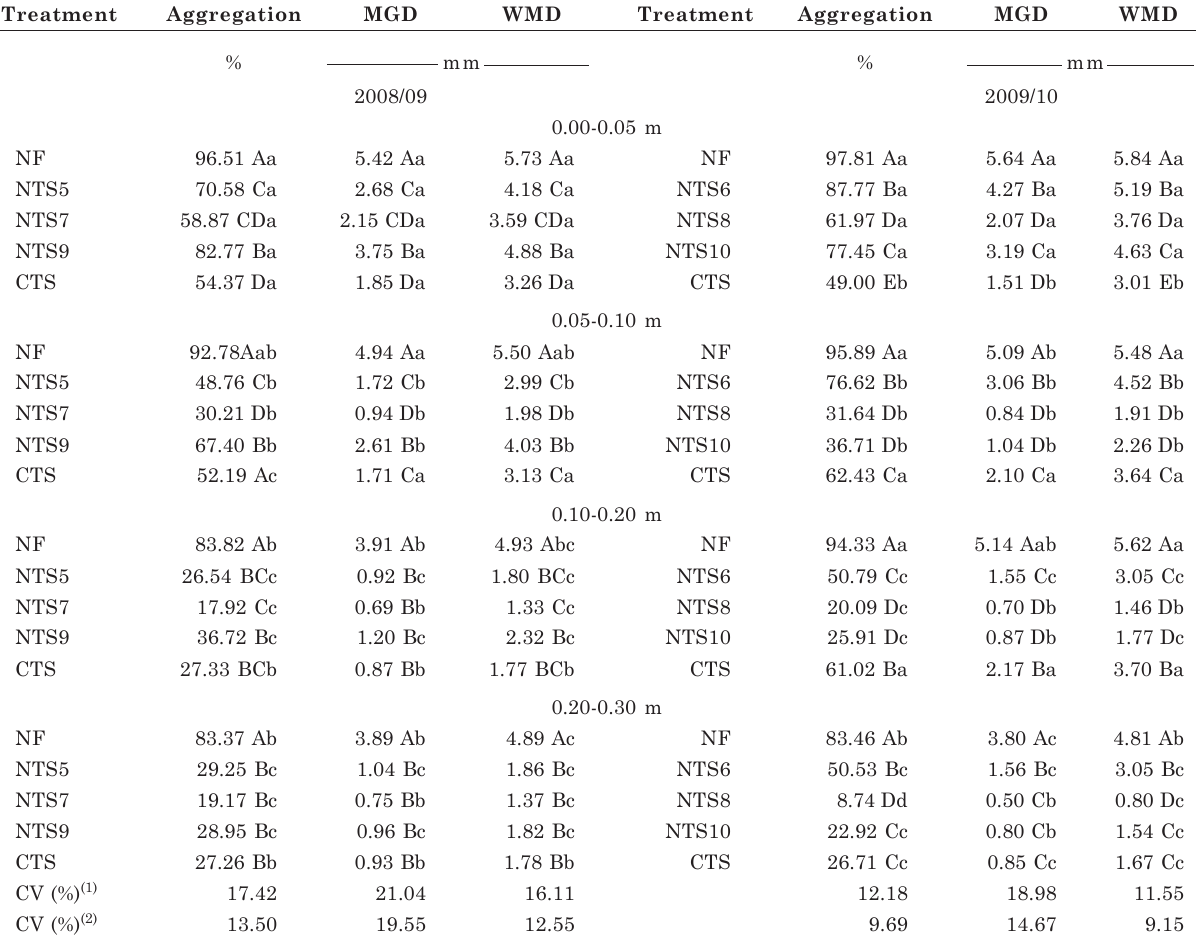
Table 1. Percentage of water-stable aggregates > 2.00 mm (Aggregation), mean geometric diameter (MGD) and weighted mean diameter (WMD) in four layers of a Red Oxisol, after different management periods and under native